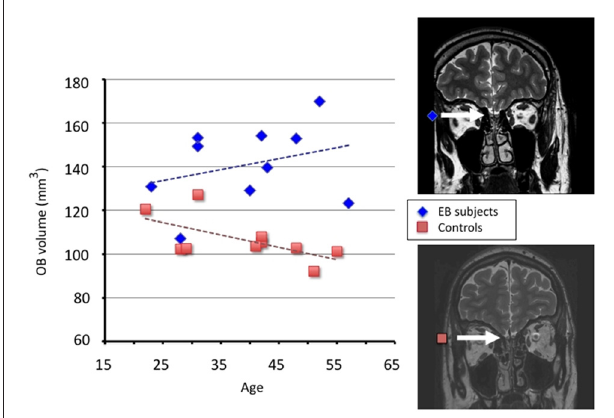
FIGURE 2 | Results from measurements of olfactory bulb (OB) volume in EB subjects and controls. Using a 3-Tesla MRI and a T2-weighted fast spin-echo sequence in 10 male subjects with early blindness and 10 matched controls, individual OB volume was calculated by plannimetric manual contouring on 23 coronal slices (1.5 mm thickness) perpendicular to the cribriform plane and covering the middle segment of the basifrontal area. Measurements were taken twice by two observers and the mean of these measurements was included as the definite volume, according to a validated protocol for OB analysis (Rombaux et al., 2009 and references therein). The OB volume (right + left) in mm 3 is plotted as a function of age in EB subjects (blue diamonds, r = 0.30) and controls (orange squares, r = − 0.62). Coronal T2 sequence MRI scans of a representative EB subject (top) and a control (bottom) are displayed at the level of OB (indicated by the white arrow). OB: occipital bulb; EB: early blind. Adapted from Rombaux et al.